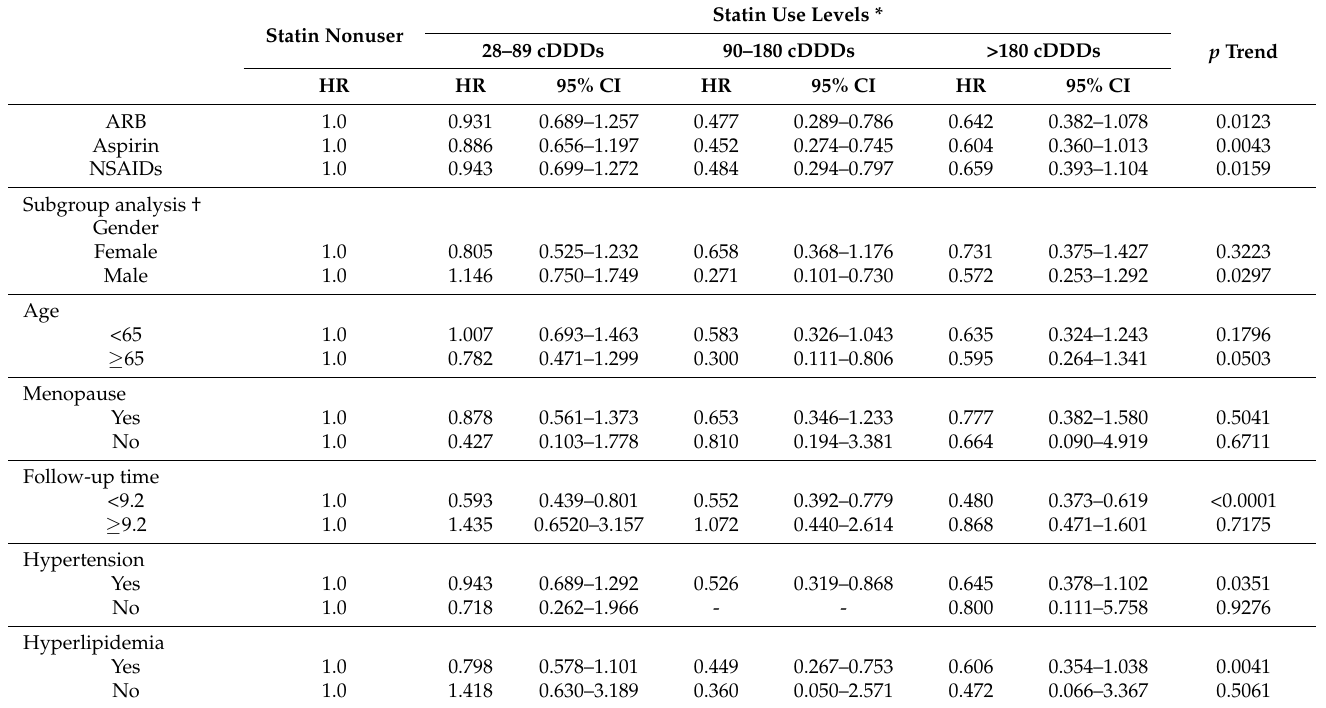
Table 3. Time-dependent covariate Cox model for the effects of statin on first-time diabetes mellitus among transient ischemic attack patients.